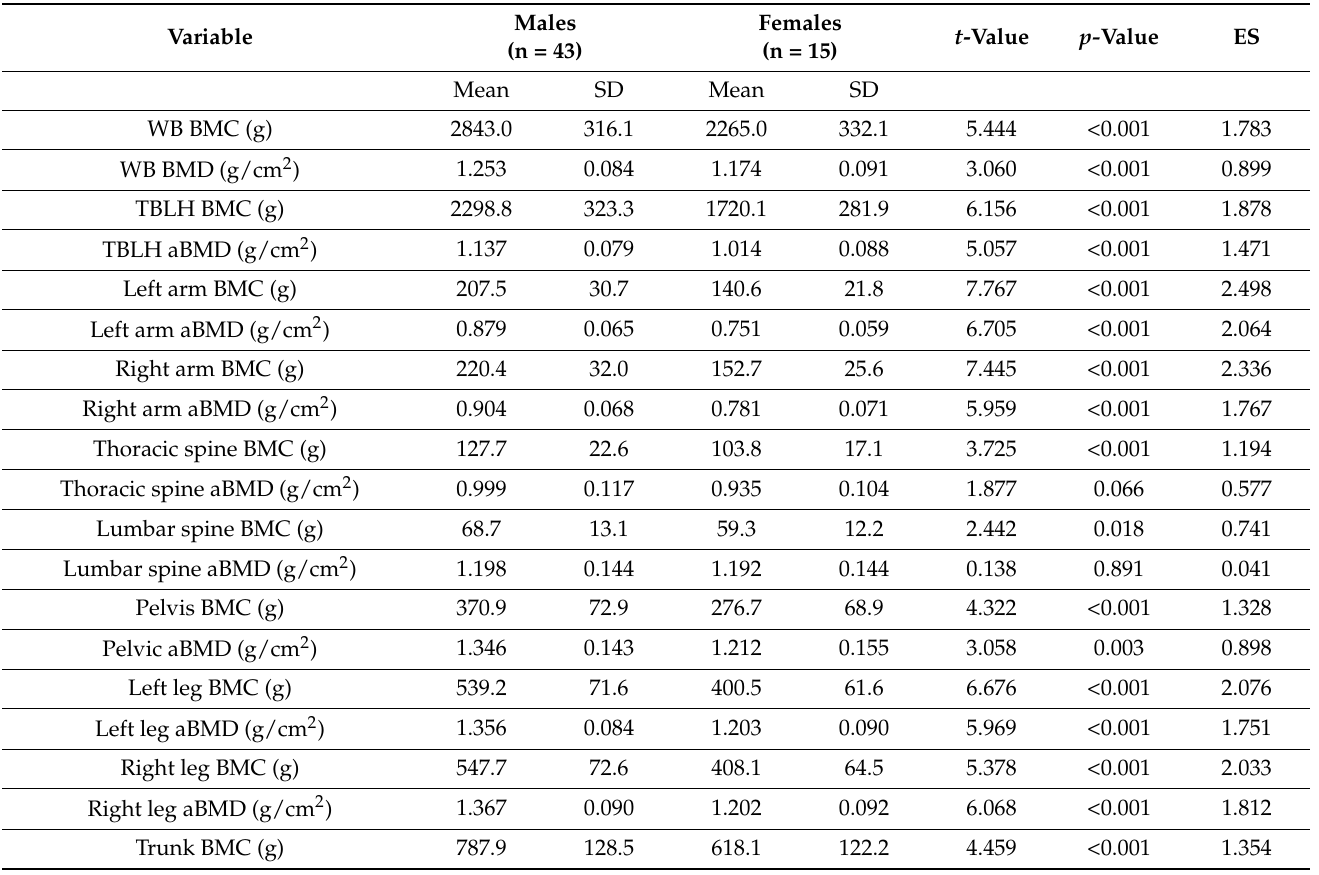
Table 2. Body composition (DXA) in male and female karatekas. Mean ± standard deviation (SD). Student’s t